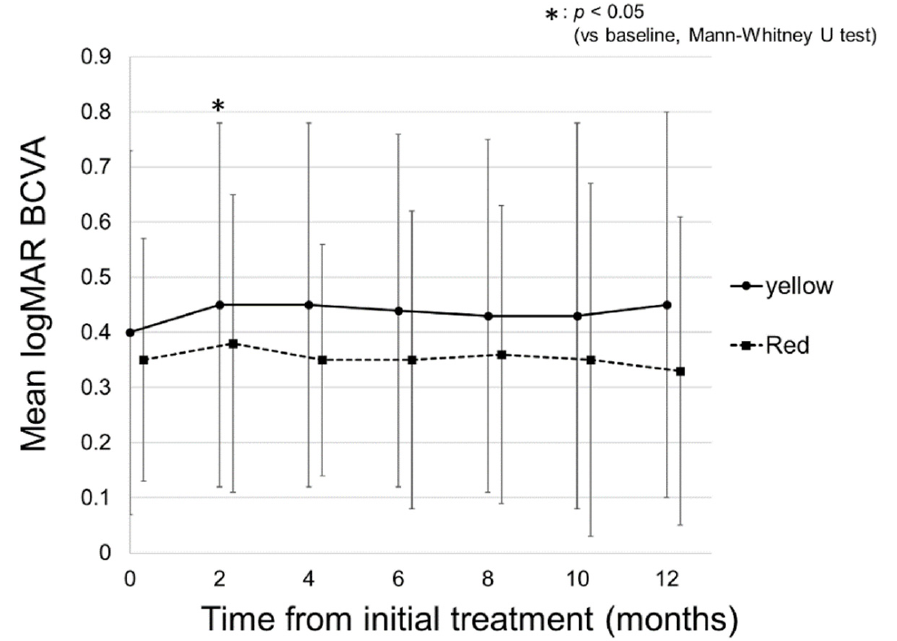
Figure 3. Changes in the mean logarithm of the minimal angle resolution (logMAR) best-corrected visual acuity (BCVA) in the yellow and red subthreshold micropulse laser (SMPL) groups. In the yellow SMPL group, the mean BCVA was 0.40 ± 0.33 at baseline and was 0.45 ± 0.33, 0.45 ± 0.33, 0.44 ± 0.32, 0.43 ± 0.32, 0.43 ± 0.35, and 0.45 ± 0.35 at 2, 4, 6, 8, 10, and 12 months, respectively. There was no significant difference between the mean BCVA at baseline and each follow-up period other than 2 months ( p = 0.015, 0.069, 0.34, 0.39, 0.53, and 0.39, respectively). In the red SMPL group, the mean BCVA was 0.35 ± 0.22 at baseline and was 0.38 ± 0.27, 0.35 ± 0.21, 0.35 ± 0.27, 0.36 ± 0.27, 0.35 ± 0.32, and 0.33 ± 0.28 at 2, 4, 6, 8, 10, and 12 months, respectively. There was no significant difference between the mean BCVA at baseline and each follow-up period ( p = 0.42, 1.00, 0.93, 0.78, 0.91, and 0.70,